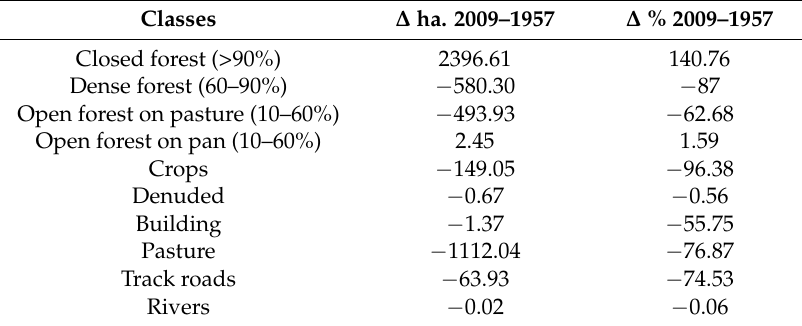
Table 4. Changes to different land use and covers between 1957 and 2009.